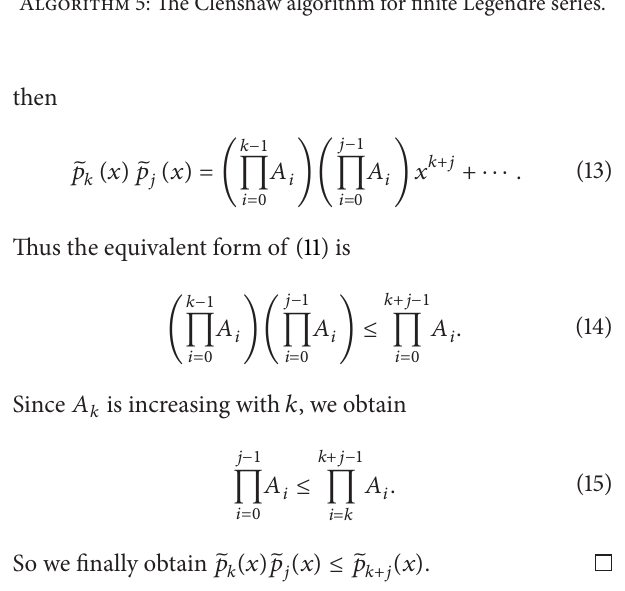
Algorithm 5: The Clenshaw algorithm for finite Legendre